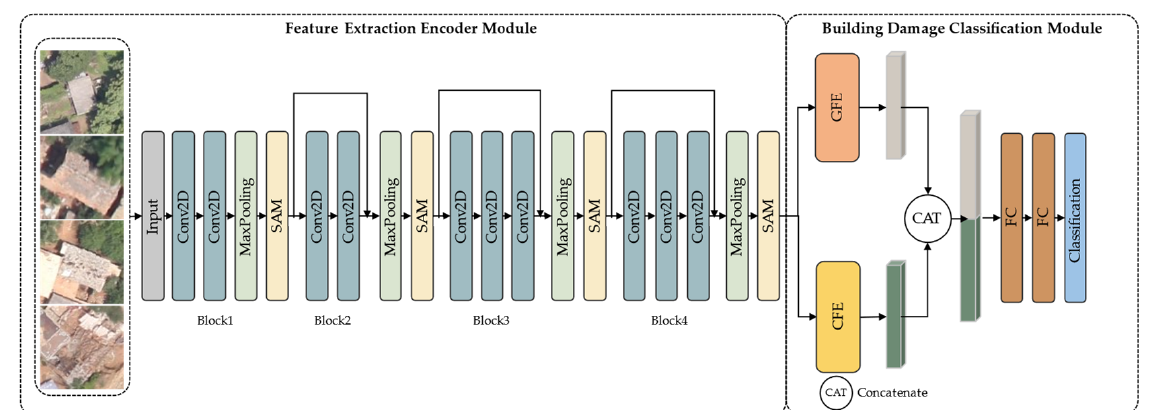
Figure 1. The framework of the proposed EBDC-Net.